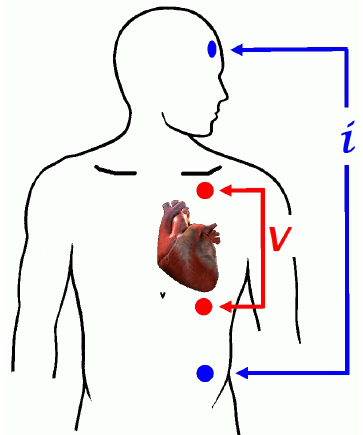
Fig.1: Electrode configuration for the measurement of ISTI: A small electrical current i was applied to the upper part of the body by means of the two outer electrodes. The two inner electrodes measured the subsequent electrical voltage difference V over the heart from which the impedance Z was